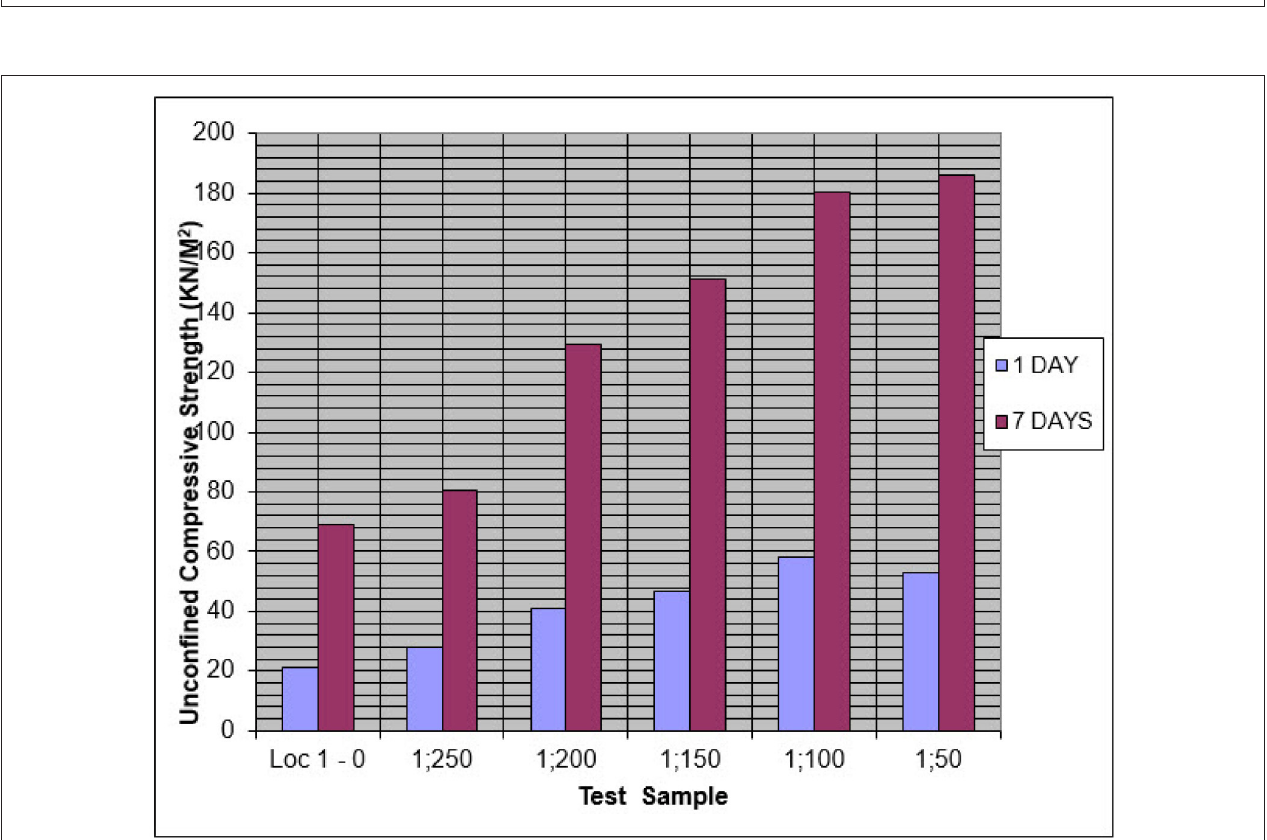
FIGURE 11 | Effect of addition of nanomaterial on the unconfined compressive strength (source: analysis of laboratory results).